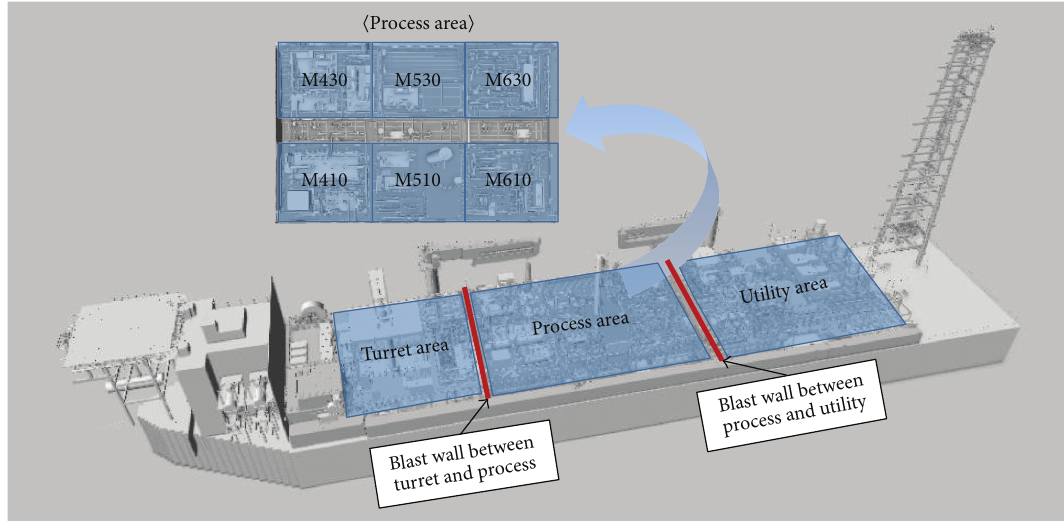
Figure 3: Layout of